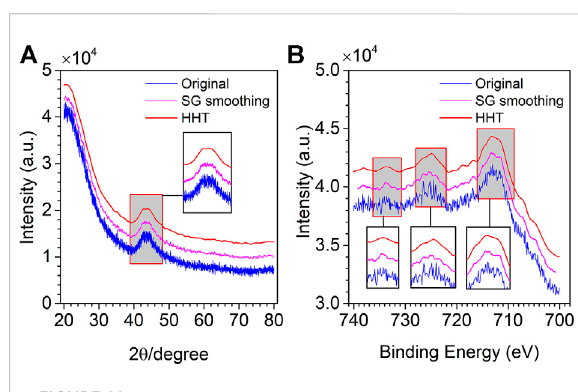
FIGURE 11 Original (blue line), SG smoothing (pink line) and HHT denoising (red line) XRD spectrum (A) and XPS spectrum (B)